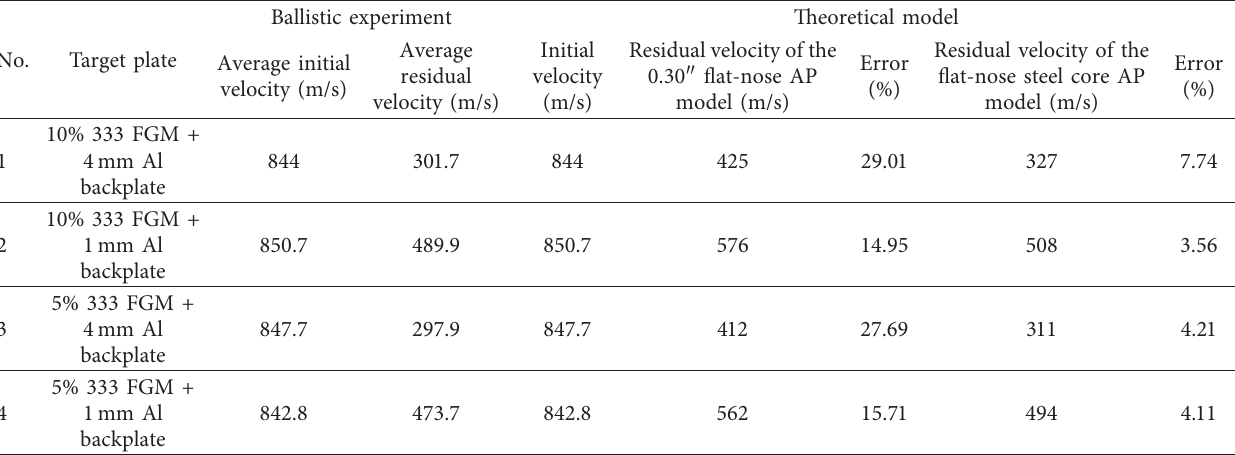
Table 7: Comparison of residual velocities.